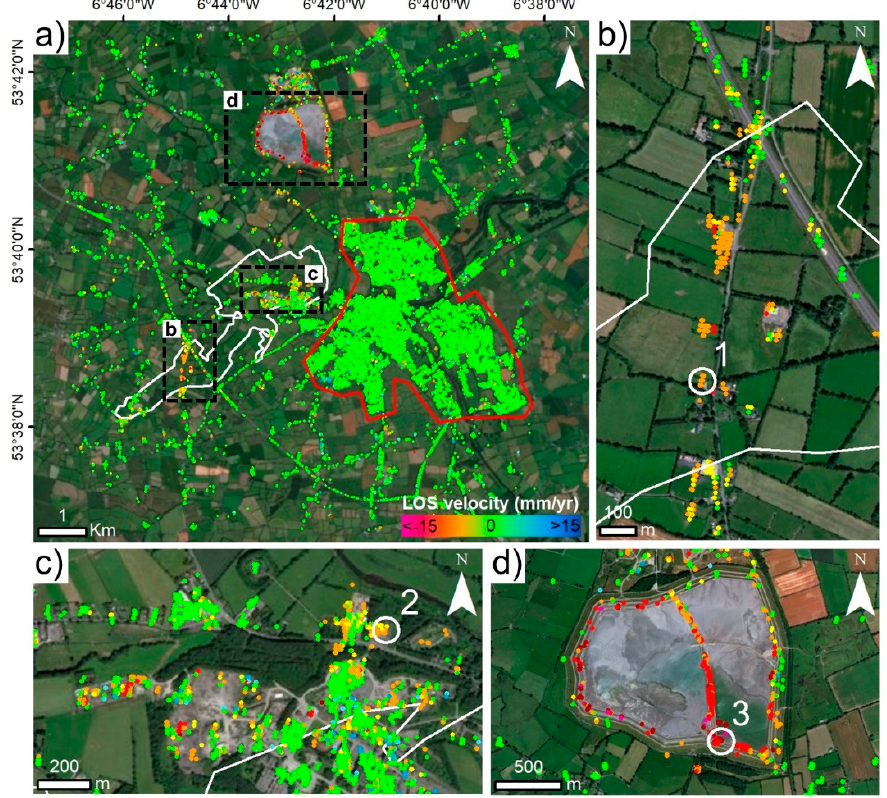
Figure 17. LOS velocity maps of AOI-2 obtained from Sentinel-1A/B images with the PS-InSAR approach. SAR imagery date range: May 2015-March 2018. ( a ) AOI-2 velocity map; ( b ) close-up map of the south-west section of the Tara mine site; ( c ) close-up map of the main mine site; ( d ) map of the Tailing Storage Facility (TSF) site. The white polygon is the simplified subsurface extent of the Navan orebody (after [46] ). The red polygon is the area used to extract the PSs for the statistical analysis reported in the Discussions. The white circles are the locations of the extracted displacement time series shown in Figure 19. Base image source: Esri, DigitalGlobe, GeoEye, Earth Geographics, CNES/Airbus DS, USDA, USGS, AeroGRID, IGN, and the GIS User Community.